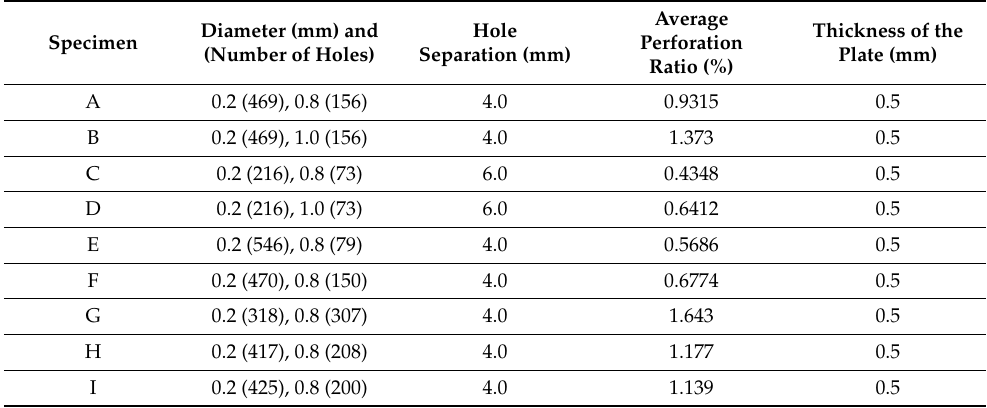
Table 5. Parameters of specimens A–I. Note that the larger hole is used for the pattern, and the smaller hole is used for the background *.